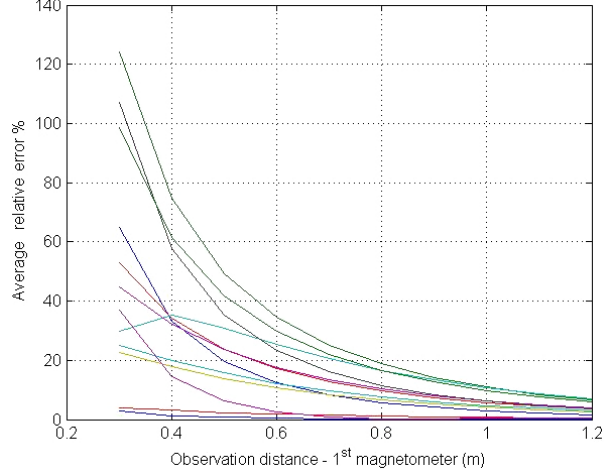
Figure 4. Magnetic field’s average relative error with respect to the first magnetometer’s position with fixed spacing 30, 40, 50, and 60cm between the magnetometers. The dipole’s field r − 3 power law is also shown for